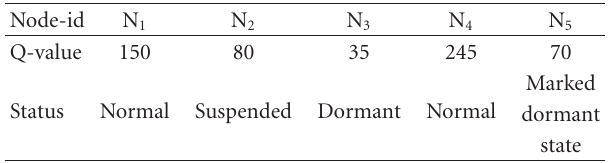
Table 1: Q-table of a